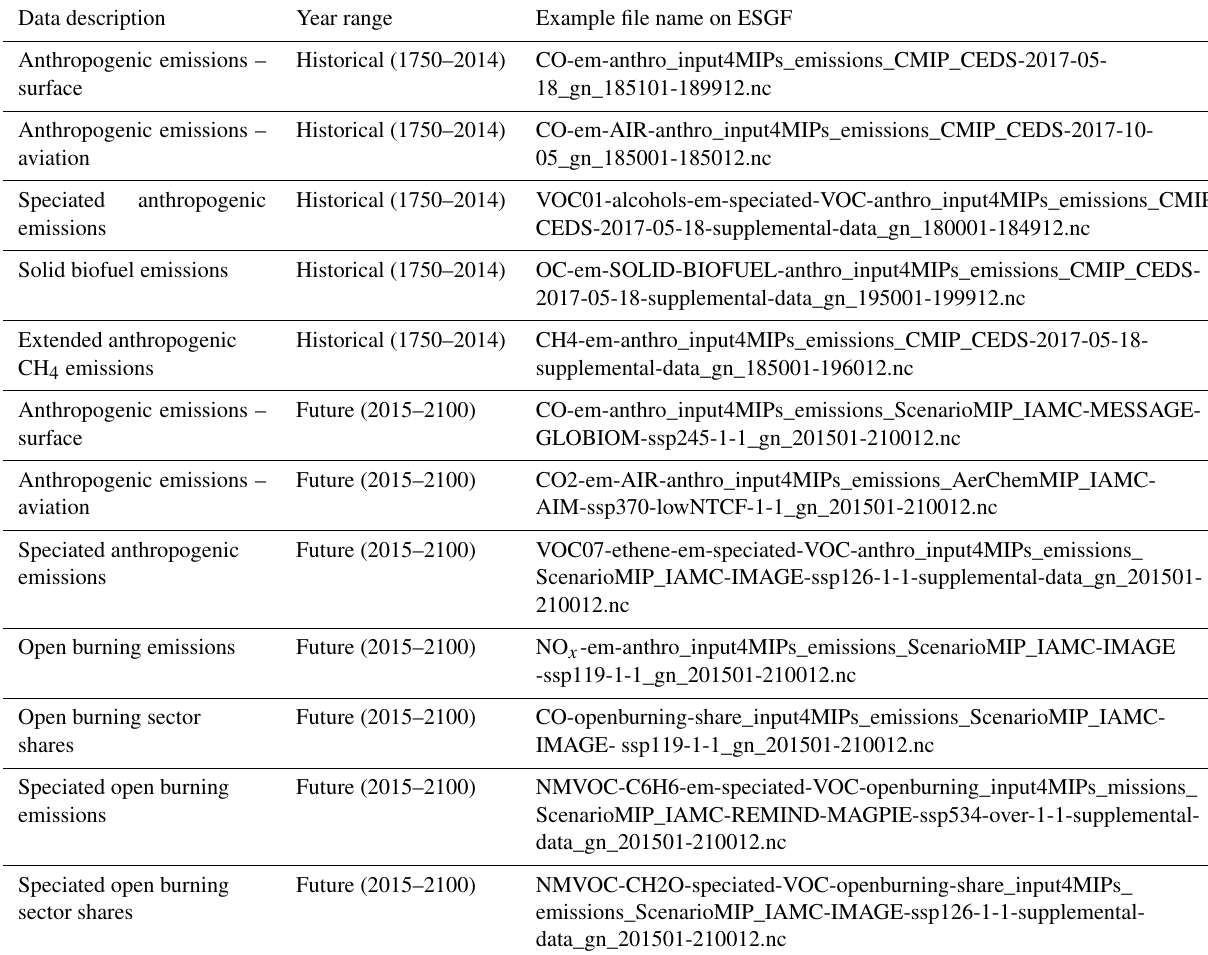
Table 4. Gridded historical anthropogenic and future scenario emission data files provided for CMIP6. The complete historical anthropogenic dataset consists of 327 files. The complete future scenarios dataset consists of 1017 files. Historical emissions are provided annually, while future emissions are provided for 2015, 2020, and in decadal intervals after that. All emissions are provided with monthly seasonality. Full data citations, including digital object identifiers (DOIs), are provided in the “Data availability” section at the end of this